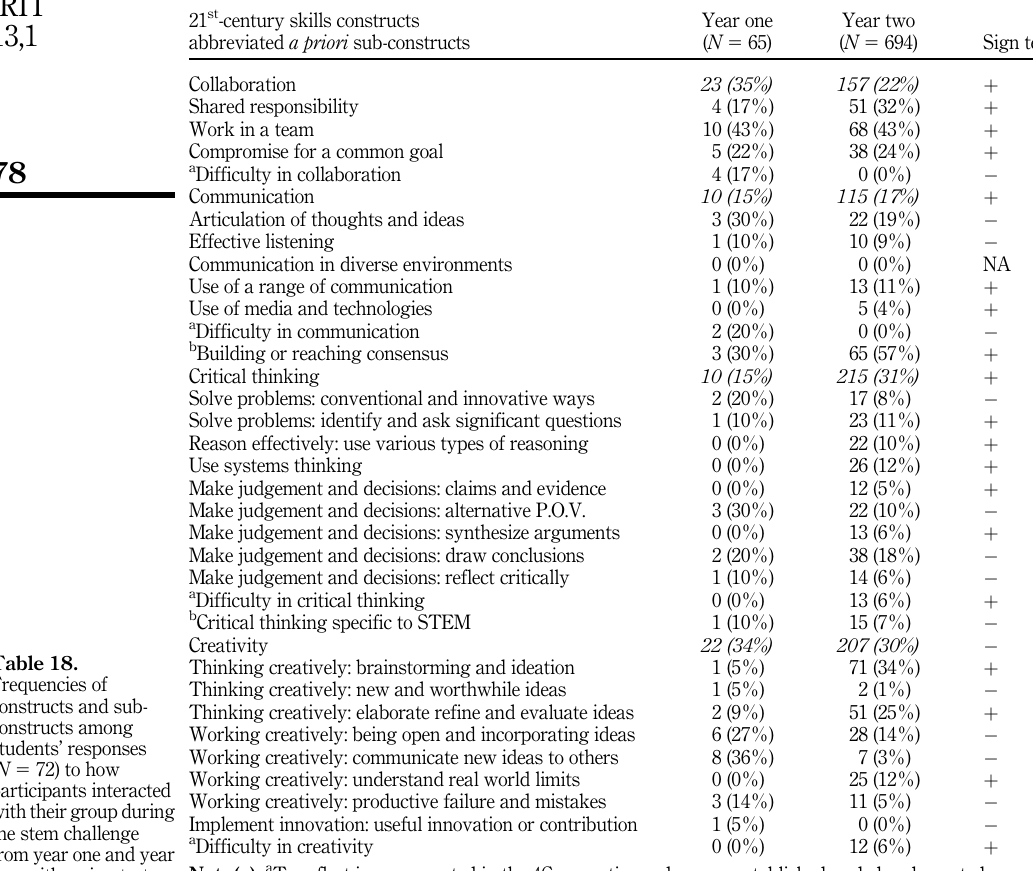
constructs and sub- constructs